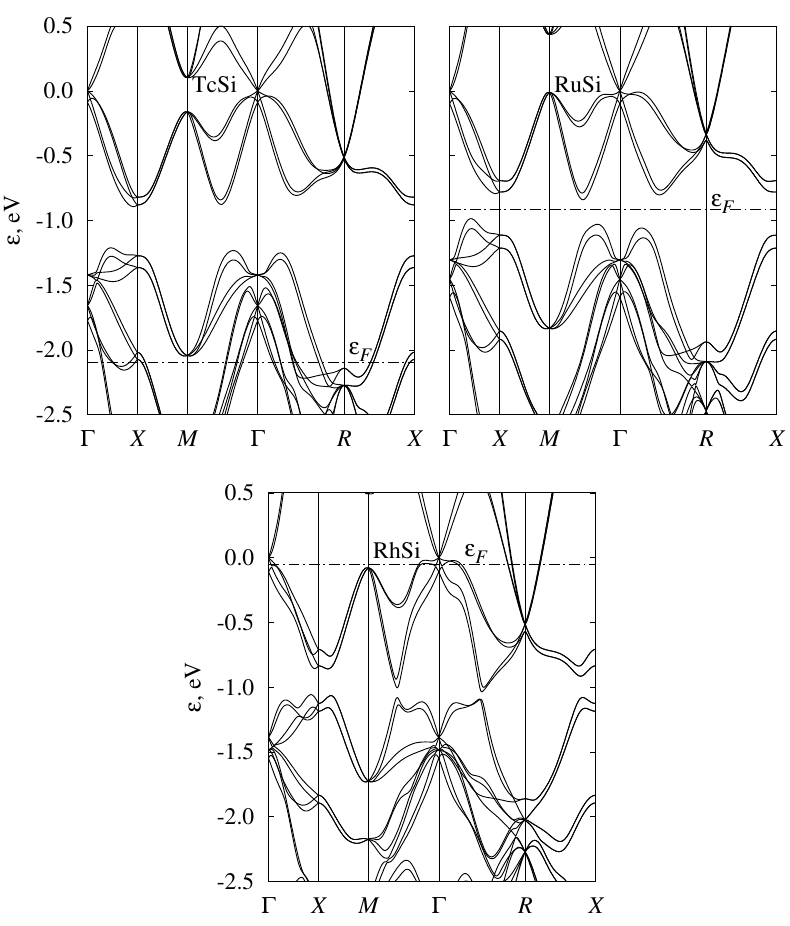
Figure 3. Band structure of TcSi, RuSi, and RhSi with B20 (P2 1 3, #198) crystal structure. Energy measured relative to fourfold band crossing at Γ point. Dash-dotted line shows Fermi level position.